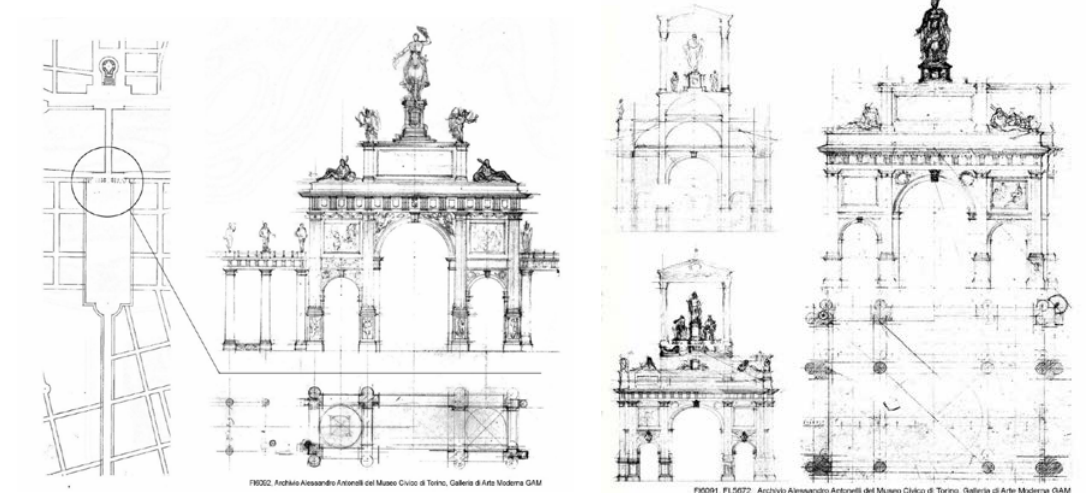
Figure 8. Original drawings with the catalogue number used by the City museum archive.